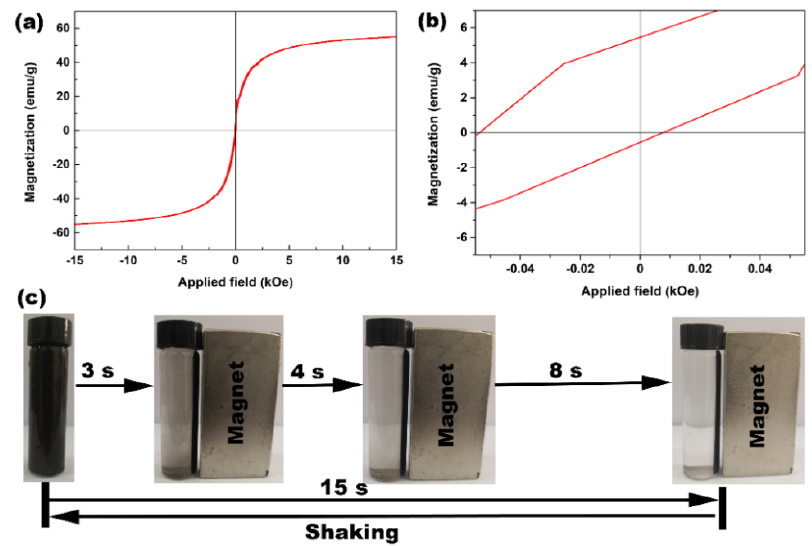
Figure 2. ( a ) Magnetic hysteresis curve of Fe 3 O 4 powders and ( b ) enlarged partial curve of the surrounding origin in ( a ); ( c ) pictures for the progressive separation of Fe 3 O 4 particles from aqueous medium upon the application of a NdFeB permanent magnet ([Fe 3 O 4 ] = 25.0 g/L; V = 8.0 mL; Distilled water; Glass bottle: d = 1.5 cm and h = 6.2 cm).